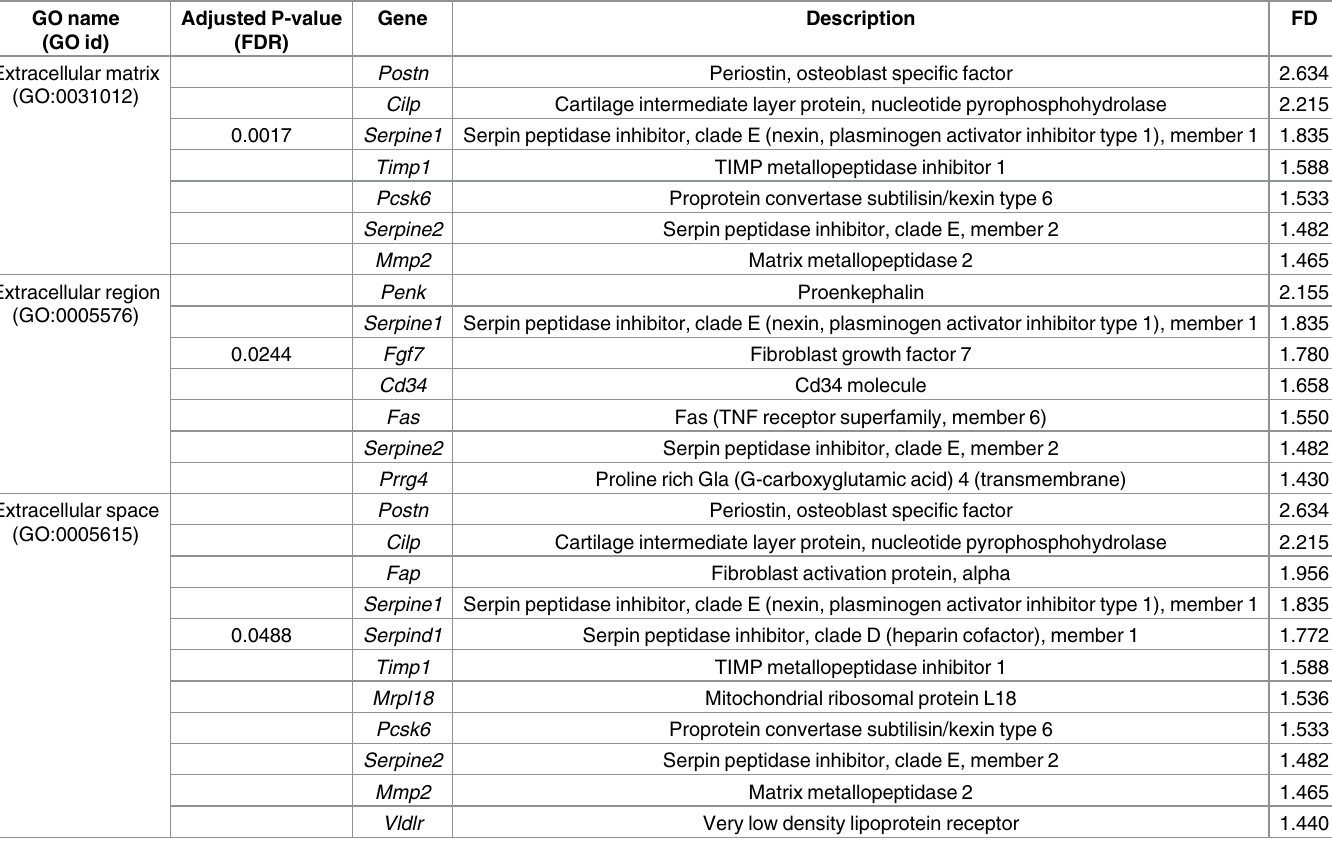
Table 1. Differentially expressedgenes from the GO ontology named cellular component with a fold difference (cid:21) 1.40. GO name (GO